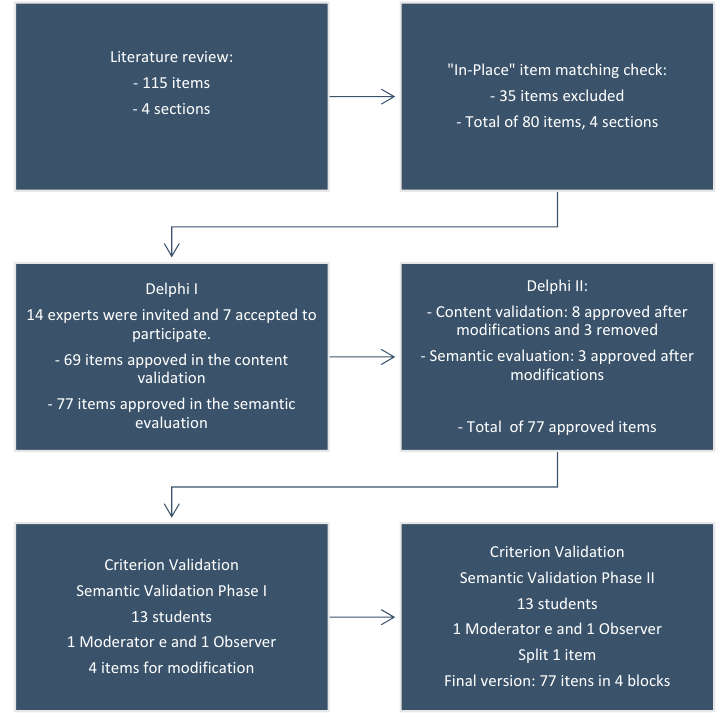
Figure 1. Stages of the instrument content validation and semantic evaluation.